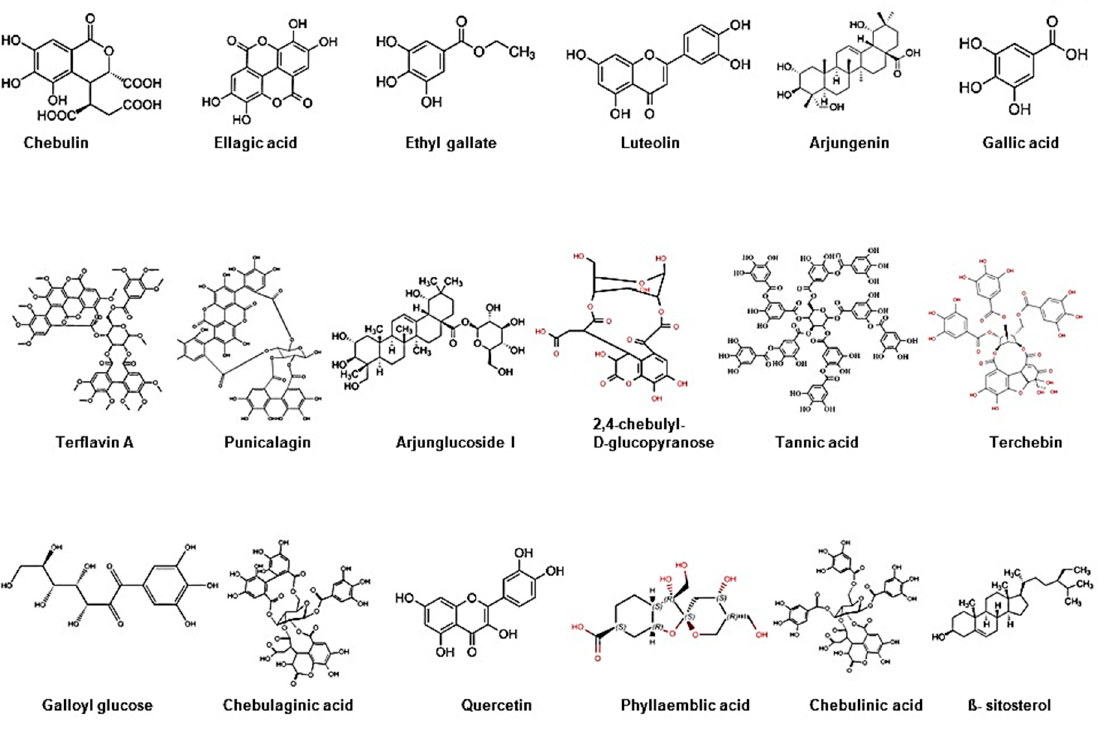
Figure 2. Chemical structure of bioactive components of Triphala.